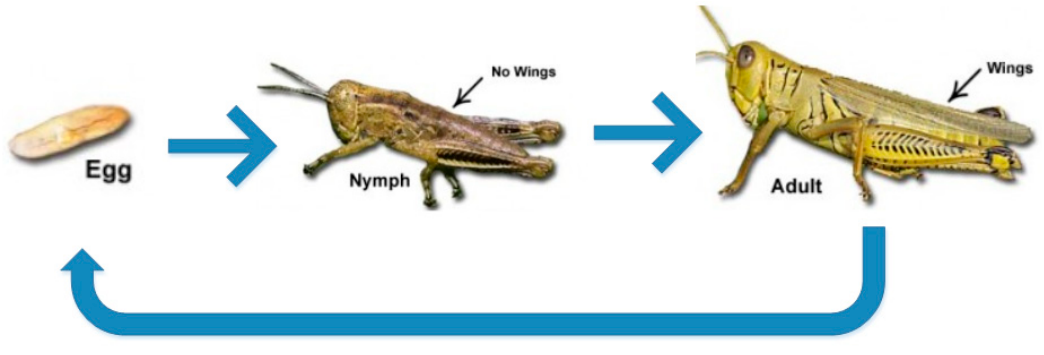
Figure 3. Series of the grasshopper life.